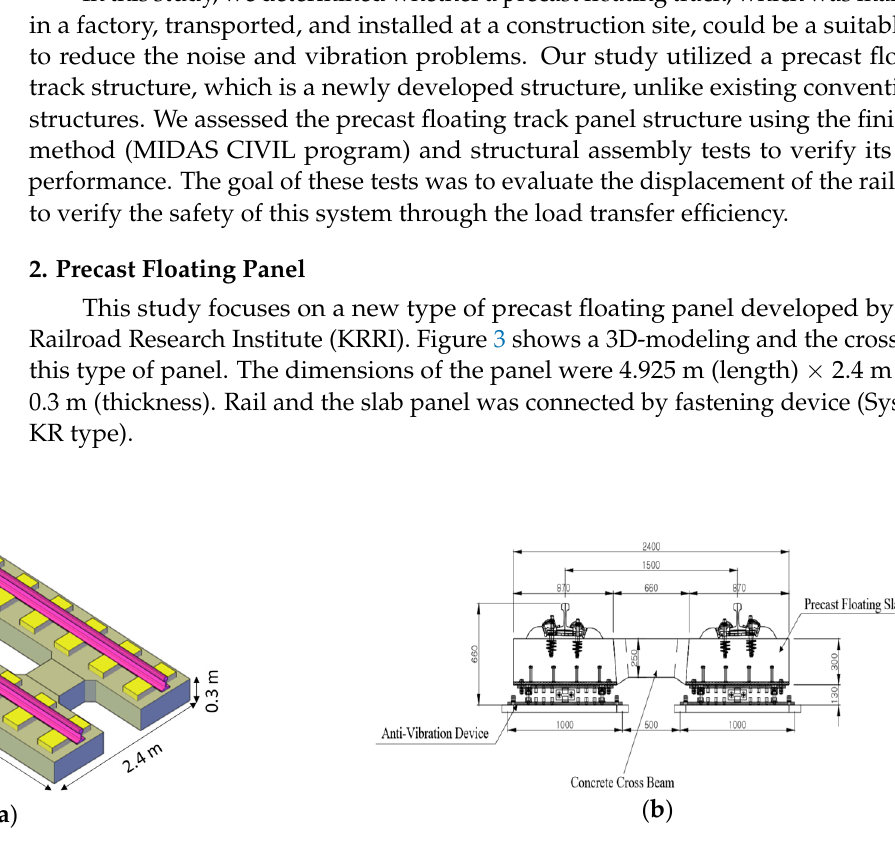
Figure 3. ( a ) Three-dimensional (3D)-modeling of the precast floating panel, and ( b ) cross-section of precast floating panel.